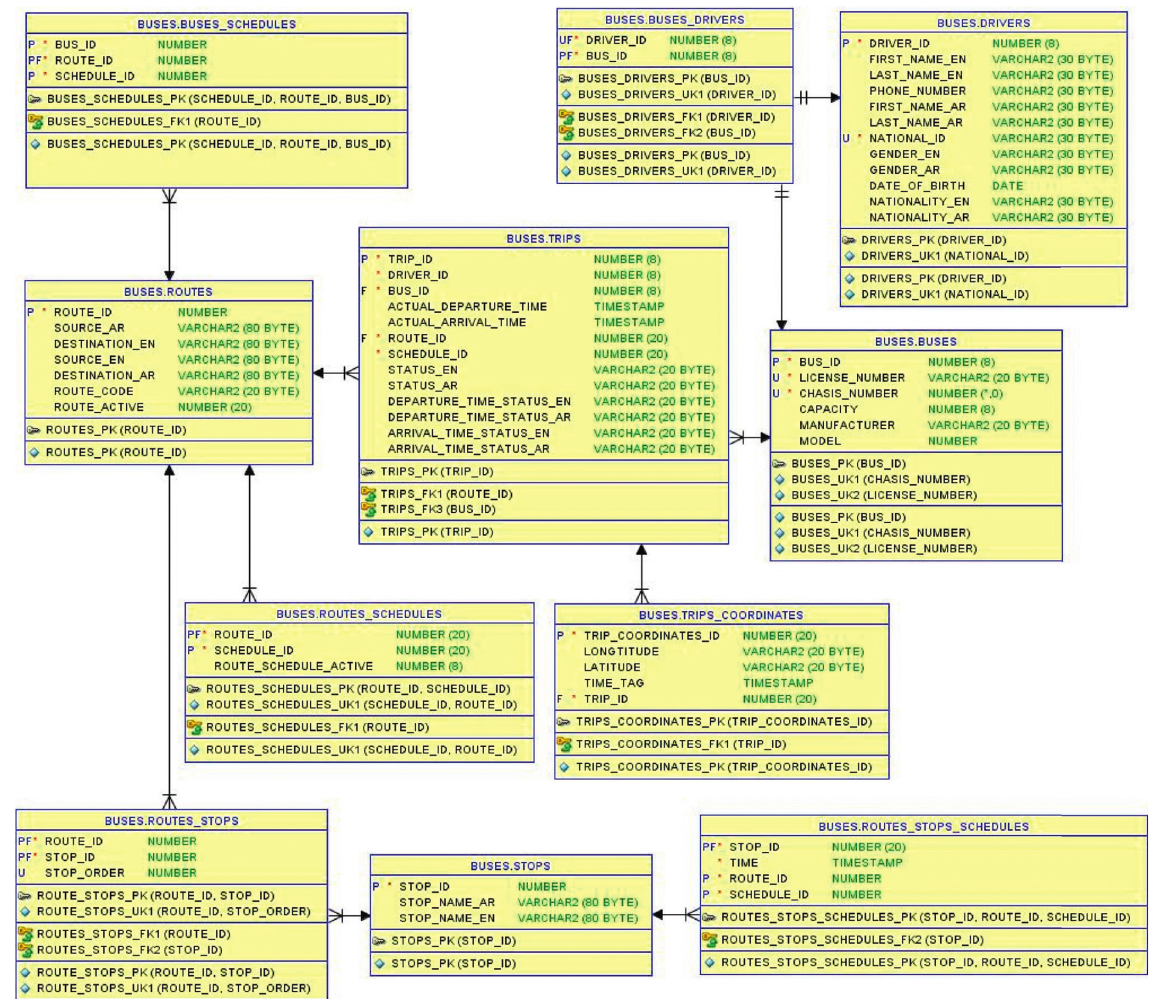
Figure 13: The ER diagram for the major tables used by the bus management system.